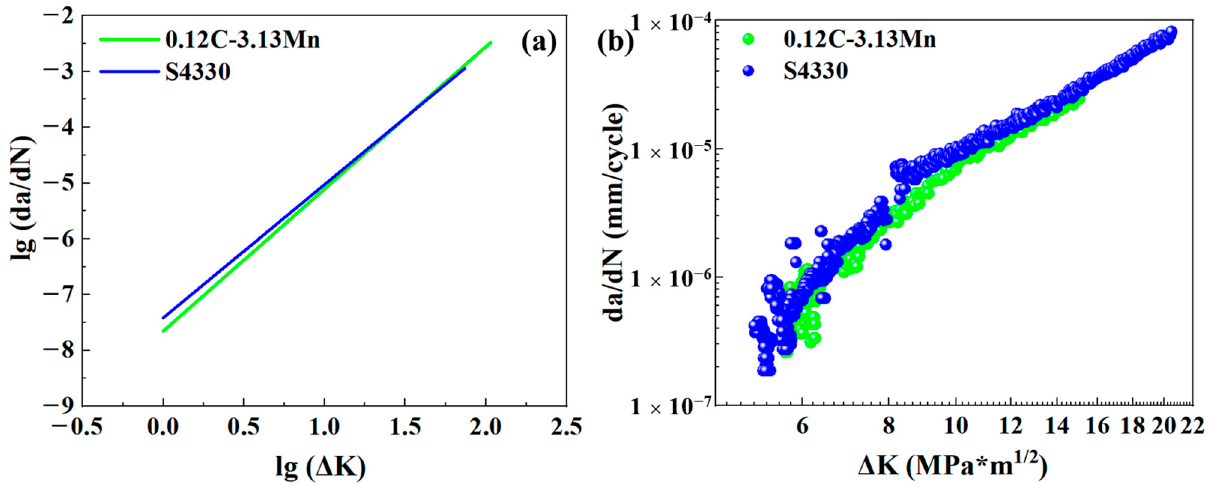
Figure 12. Δ K th of ( a ) 0.12C-3.13Mn steel and ( b ) S4330 steel. Figure 12. ∆ K th of ( a ) 0.12C-3.13Mn steel and ( b ) S4330 The fitting goodness was 0.9954 and 0.9874 for 0.12C-3.13Mn steel and S4330 steel, respectively, showing high fitting accuracy. The calculated Δ K th for 0.12C-3.13Mn steel and S4330 steel were 5.23 and 4.88 MPa*m 1/2 , respectively. The experimental result showed